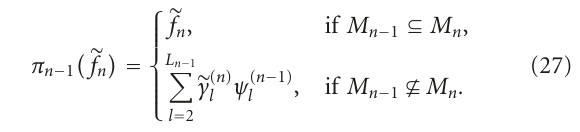
Algorithm 2: Sparsification scheme by a sequence of finite-dimen- sional linear subspaces.